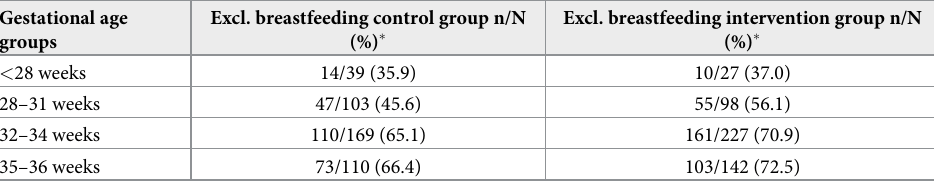
Table 4. Exclusive breastfeeding rates according to gestational age